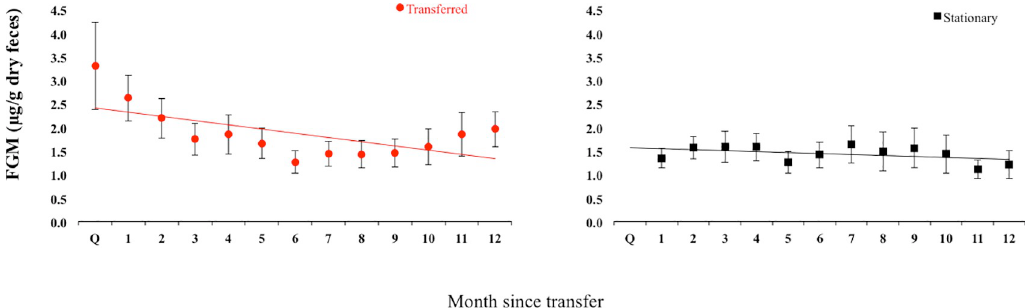
Fig 3. Effect of time on fecal glucocorticoid metabolites (FGM). A negative effect of time on mean FGM concentrations by transfer month was found using a regression analysis on transferred (y = -0.0897x + 2.5003; R 2 = 0.38; P = 0.003), but not stationary cats (y = -0.0206x + 1.5868; R 2 = 0.19; = 0.299). Particular note should be taken to the Quarantine period and the first 2 months post release from quarantine for the cats that were transferred, which corresponds to the mean time period calculated for fishing cats to return to baseline after institutional